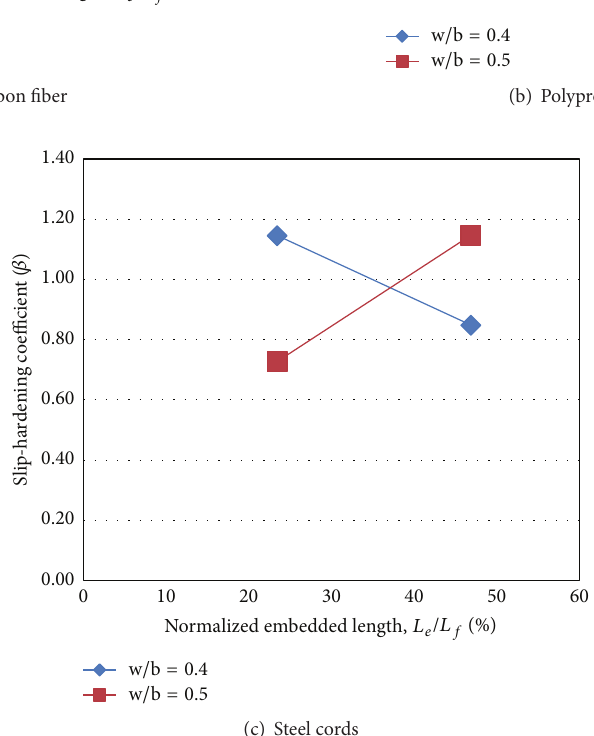
Figure 9: Slip-hardening coefficient ( 𝛽 ) with respect to normalized embedment length ( 𝐿 𝑒 /𝐿 𝑓 ).